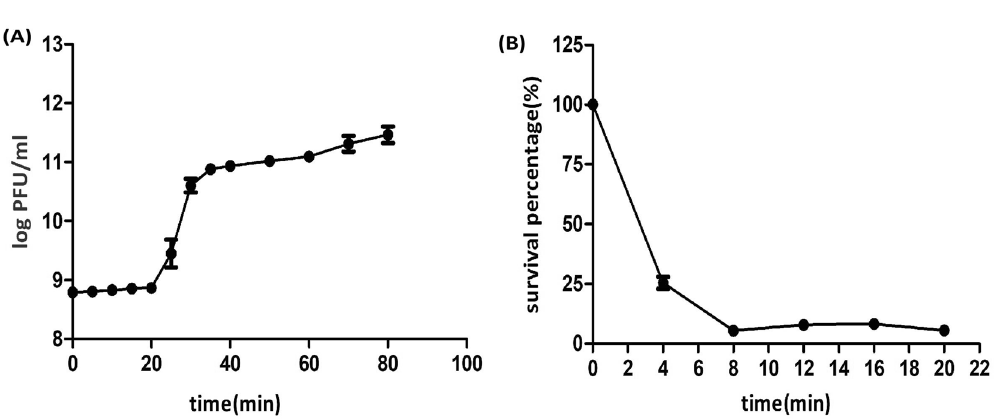
Figure 3. Growth characteristics of phage Sfk20; ( A ) One step growth experiment and ( B ) adsorption